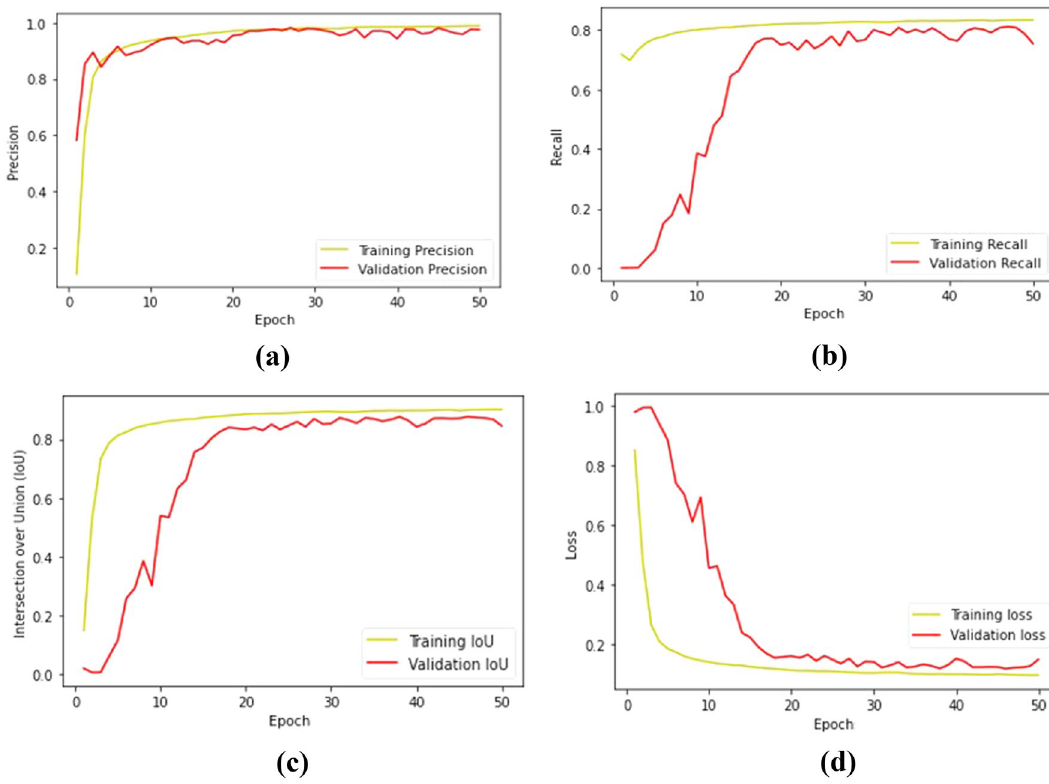
Figure 5. Performance metrics graph for training and validation ( a ) training and validation for precision, ( b ) training and validation for recall, ( c ) training and validation for IoU, ( d ) training and validation for loss.